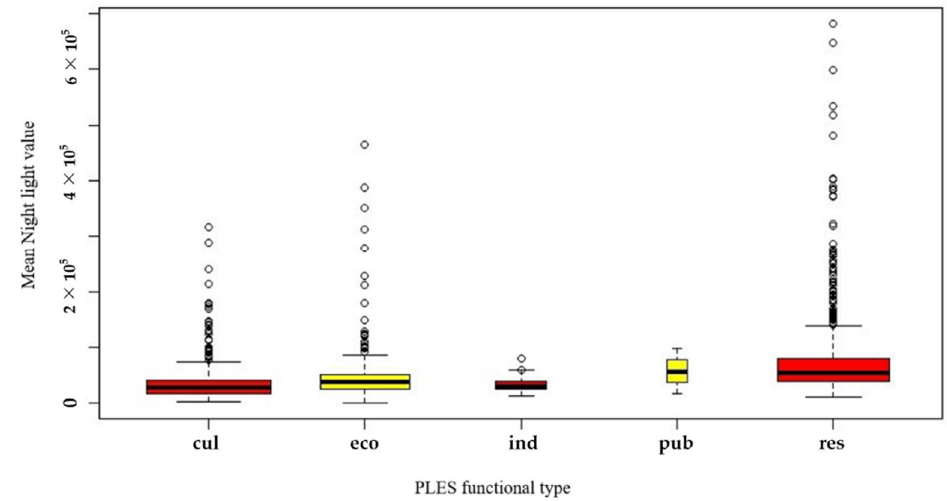
Figure 7. Mean night light value visualization of different functional areas. (Boxes of different colors represent different block types, box width represents the number of samples, scattered points on the same alignment with each box represent abnormal values, and two horizontal lines above and below the box represent quartile lines) .